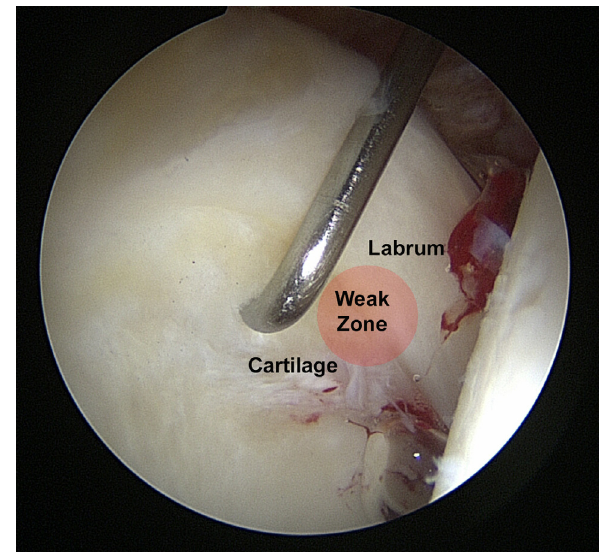
Figure 2. Damage of the chondrolabral transition (‘‘weak zone’’) in a cam FAI.